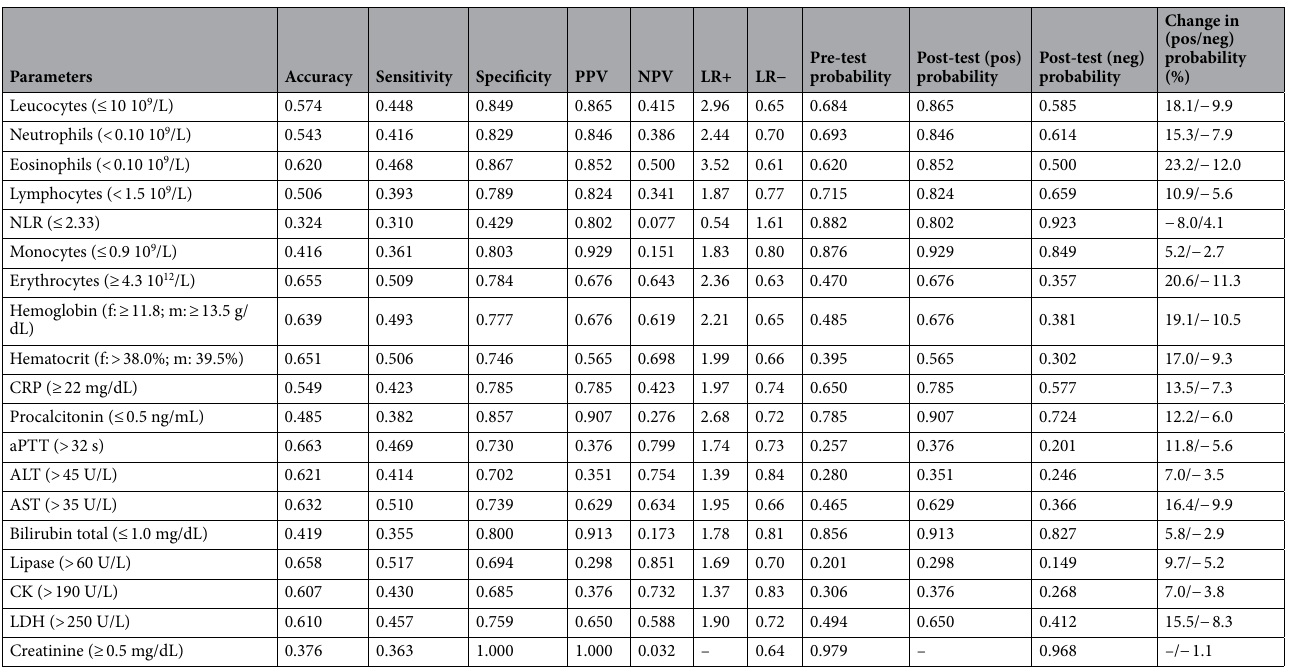
Table 5. Diagnostic performance of single standard categorical blood laboratory parameters to distinguish between COVID-19 positive from negative tested patients. Abbreviations: ALT alanine aminotransferase, aPTT activated partial thromboplastin time, AST aspartate aminotransferase, AUC area under the curve, CK creatine kinase, CRP C-reactive protein, LDH lactate dehydrogenase, NLR neutrophil-to-lymphocyte